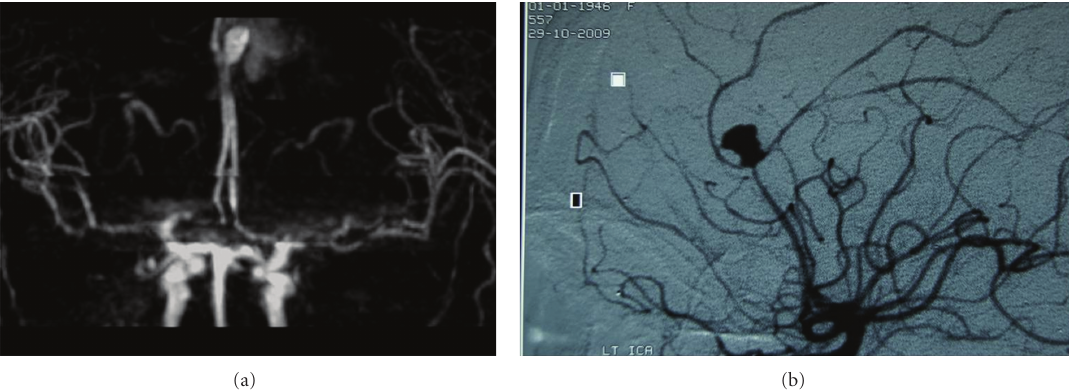
Figure 3: (a) 3D TOF MRA performed at 3 T clearly shows the pericallosal aneurysm. However, MRA also shows the surrounding hemorrhage, which slightly obscured the images, even though the aneurysm is clearly depicted. (b) DSA clearly identifies the aneurysm without superimposed